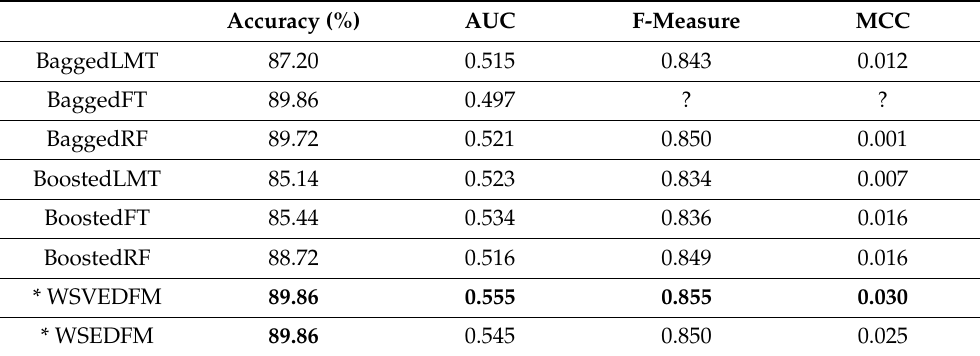
Table 12. The CCP performance comparison of WSVEDFM and WSEDFM with Bagged and Boosted DF models on Dataset 2.